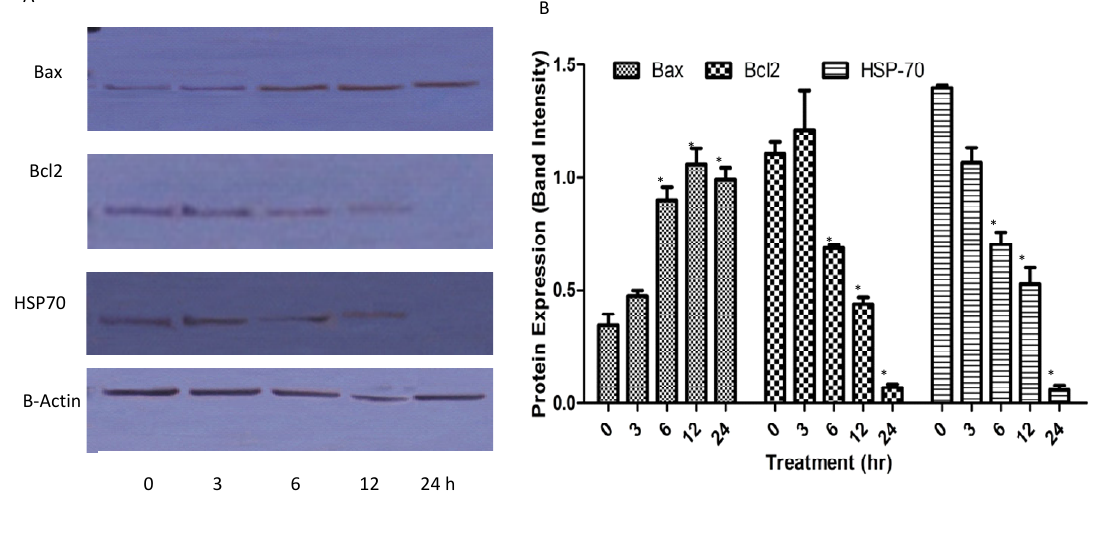
Figure 8. Effect of TQ on the levels of apoptosis regulatory proteins at 3, 6, 12 and 24 h with β - actin as a loading control. ‘*’ indicates statistically significant at p < 0.05.